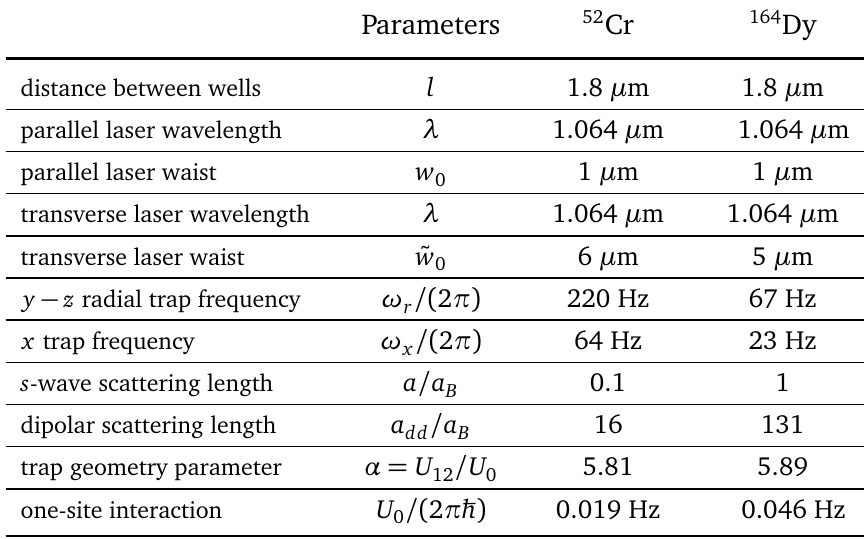
Figure 11: Schematic representation of the trap geometry. The three cigar-shapes (purple) represent the dipolar Bose-Einstein condensates, trapped in a triple-well potential formed by three parallel beams (blue), with waist w crossed by a transverse beam (green) with waist ˜ w distance l = 1.8 µ m. The dipolar atoms are aligned to the z -axis by a magnetic field (red arrows). Table 1: Experimental values and resulting parameters for 52 Cr and 164